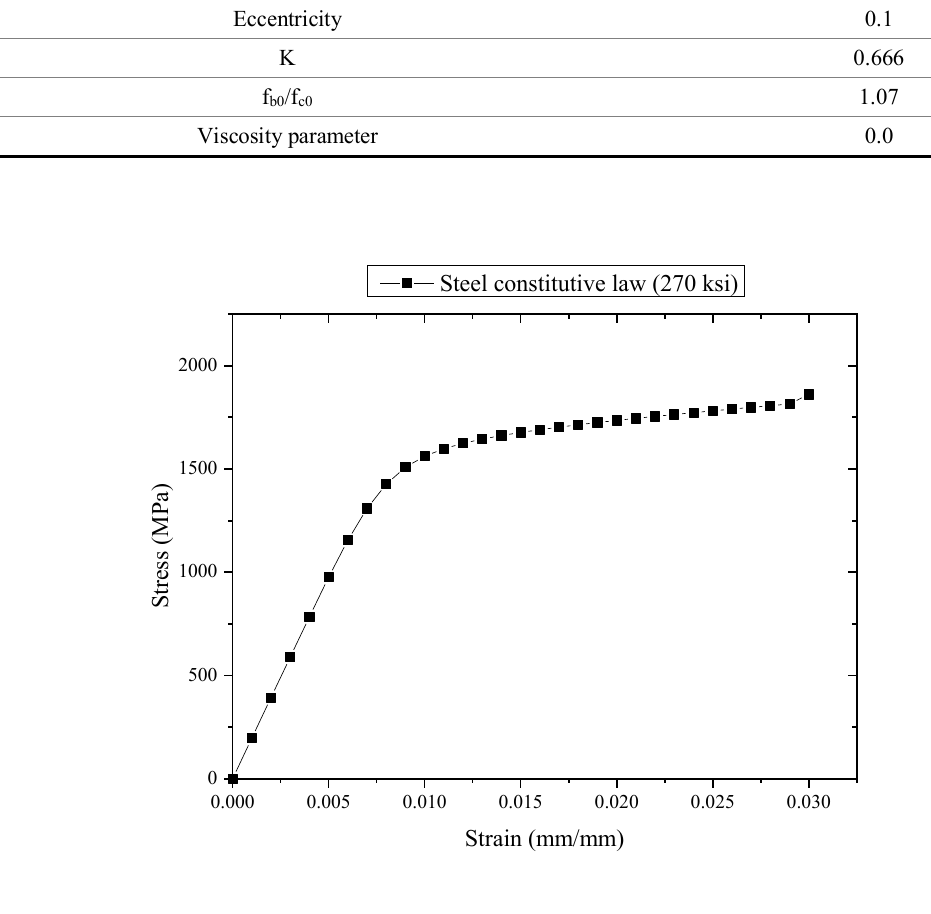
Figure 5. Steel bar constitutive law - ASTM